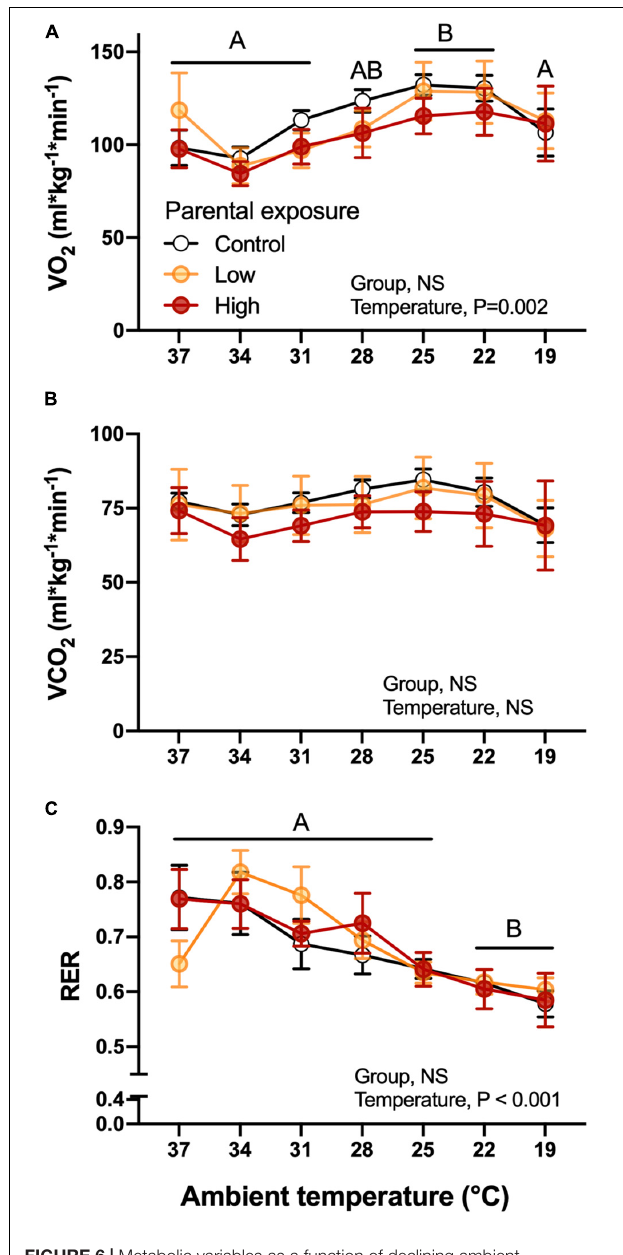
FIGURE 6 | Metabolic variables as a function of declining ambient temperature in 7–8 day old king quail hatchlings (F 1 ) derived from parents (P 0 ) exposed to control conditions or Low or High oil exposure through diet. (A) Oxygen consumption ˙VCO 2 , (B) carbon dioxide production (˙VCO 2 ), and (C) respiratory exchange ratio (RER). Data are expressed as mean ± 1 standard error of the mean. Different letters indicate statistical differences of mean temperature values at specified ambient temperatures in comparison to the 37 temperature values. n = 4–8 per data point.